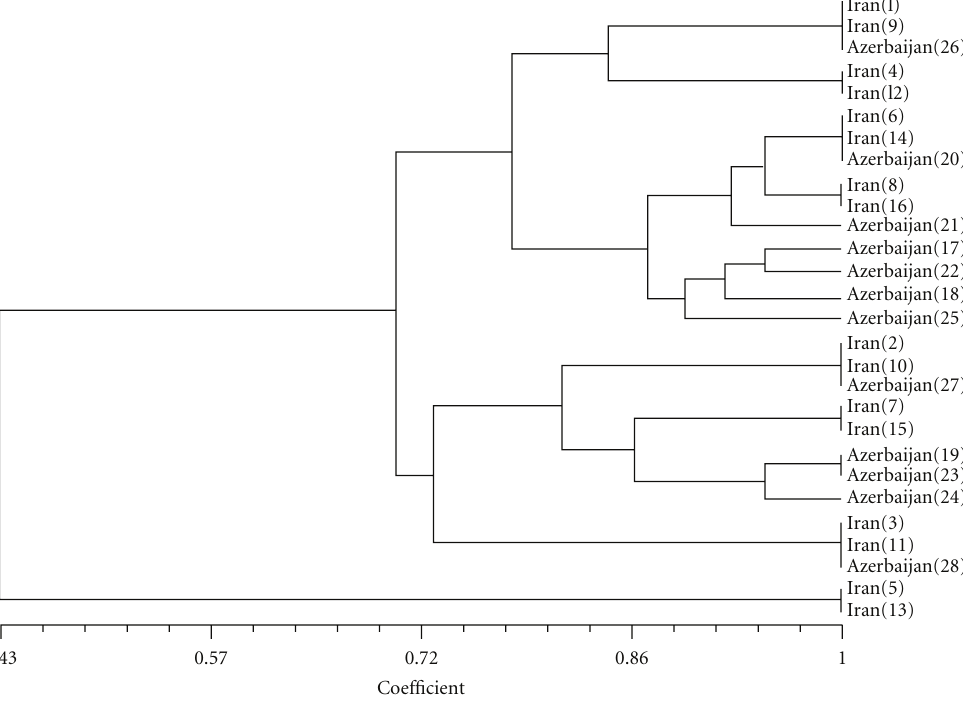
Figure 6: Cluster analysis of PCR-RAPD result using NTSYS software.